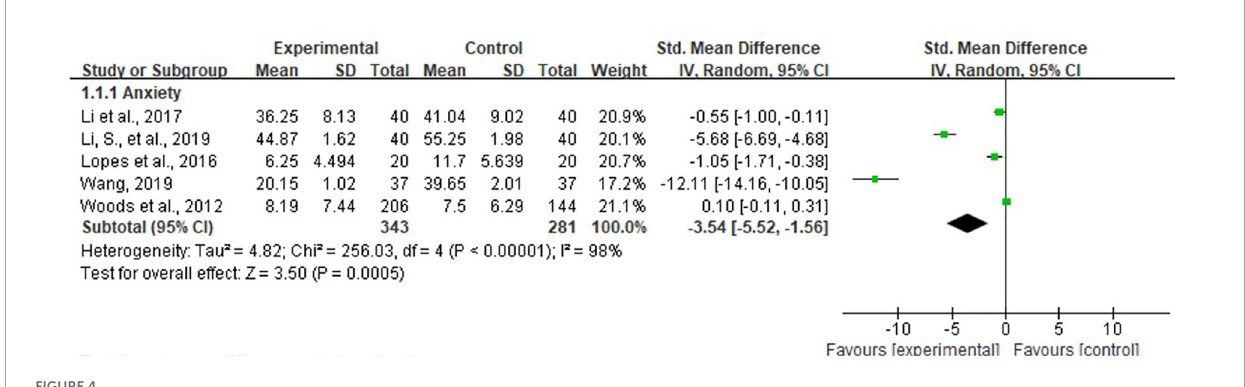
FIGURE4 Effect size of the intervention group versus the control group on anxiety rating scores.